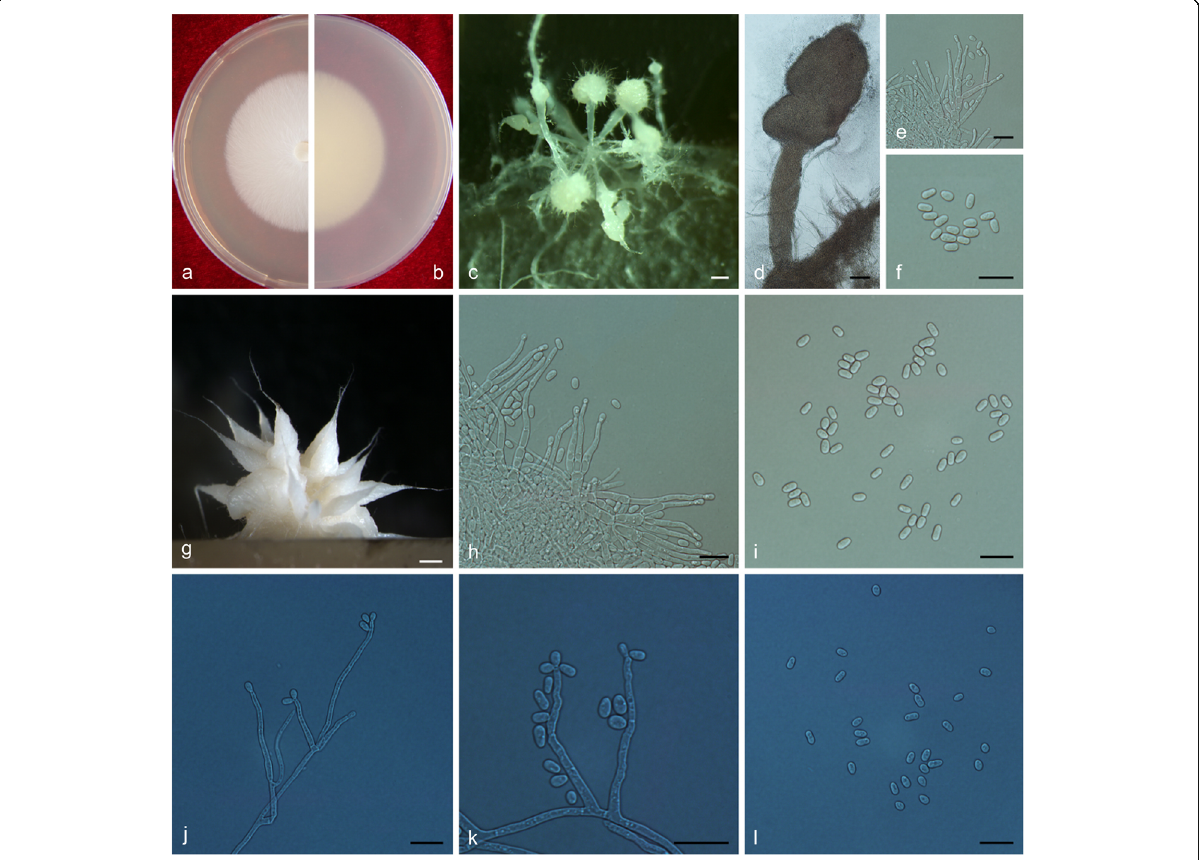
Fig. 14 Morphological characteristics of Ophiostoma lotiforme sp. nov. (CFCC 52691, Taxon 3). a – b. Fifteen-day-old cultures on 2% MEA; c – d. Pesotum-like asexual morph; e – f. Conidiogenous cells of pesotum-like asexual morph and conidia; g. Lotus-shaped conidiomata; h – i. Conidiogenous cells of lotus-shaped conidiomata and conidia; j – l. Hyalorhinocladiella-like asexual morph: conidiogenous cells and conidia. Scale bars: c = 200 μ m; d = 100 μ m; e – f = 10 μ m, g = 200 μ m; h – l = 10 μ